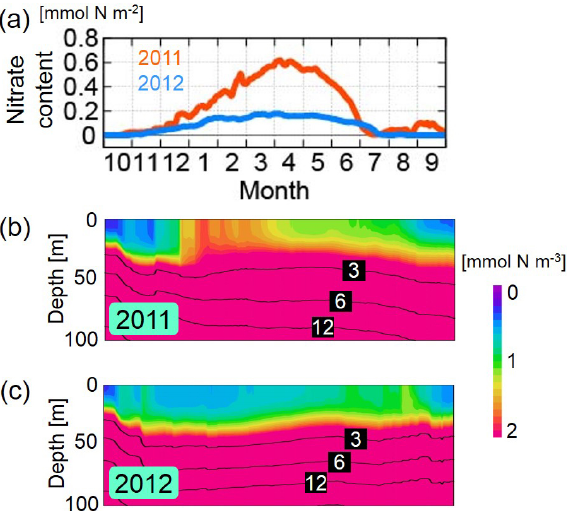
Figure 8. Modeled seasonal transition of nitrate concentration (a) in the skeletal layer (mmol Nm − 2 ) and (b–c) in the top 100m of water columns (mmol Nm − 3 ) . Red line in (a) and vertical profile in (b) correspond to the 2011 case. Blue line in (a) and the profile in (c) correspond to the 2012 case.